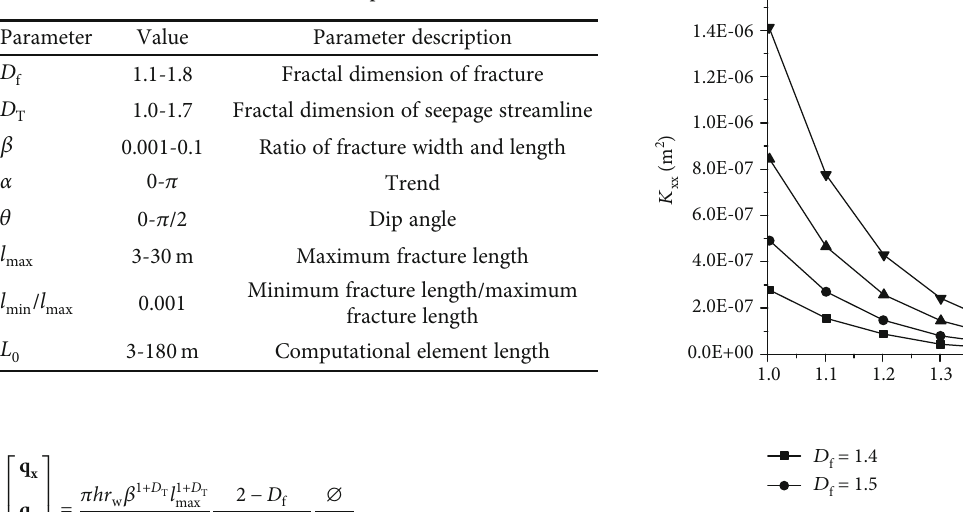
Figure 5: The relationship between K and α = π /2 ) .